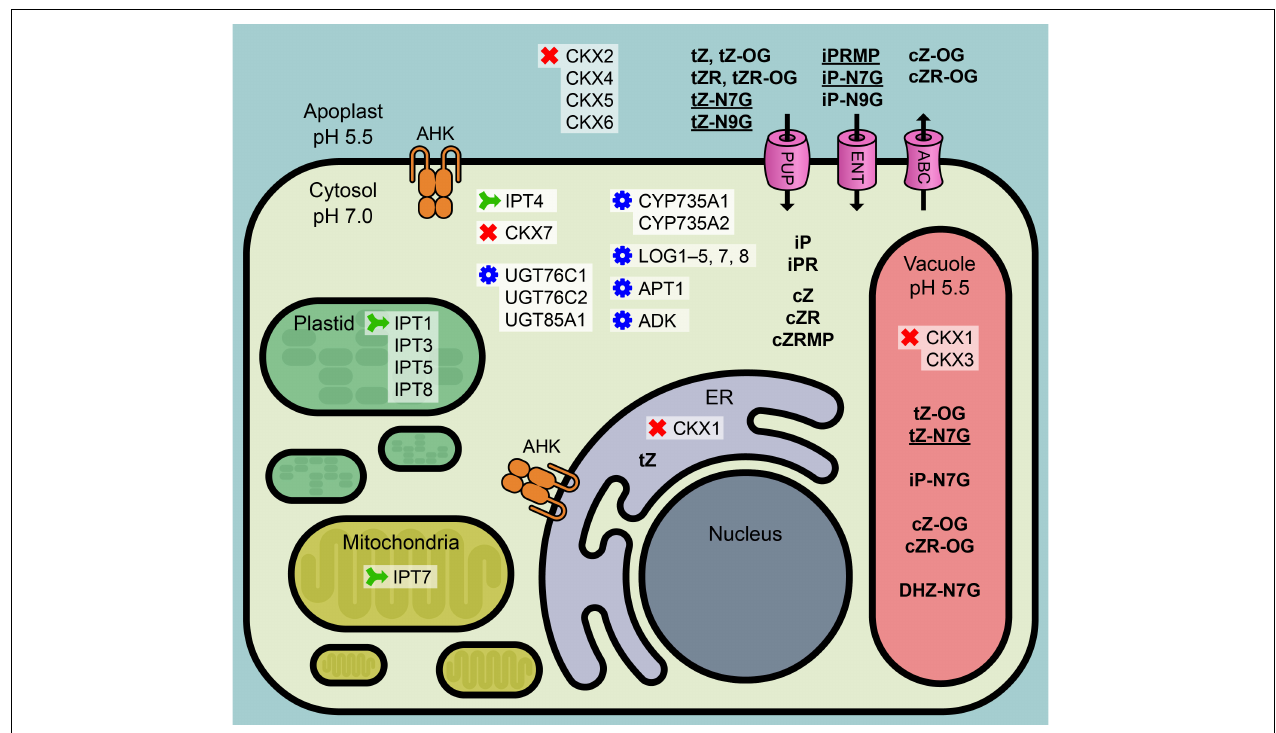
FIGURE 1 | Condensed overview of CK-related metabolic mechanisms in Arabidopsis cell. CK metabolic enzymes: green – biosynthesis, red – degradation, blue – conversion. IPT, isopentenyltransferase; UGT, UDP-glucosyltransferase; LOG, Lonely Guy, CK phosphoribohydrolase; CYP735A, cytochrome P450 mono-oxygenase; APT, adenine phosphoribosyltransferase; ADK, adenosine kinase; CKX, cytokinin oxidase/dehydrogenase. Pink – possible plasma membrane transporters: PUP, purine permeases; ENT, equilibrative nucleoside transporters; ABC, ABC transport proteins. Orange mark: AHK, Arabidopsis histidine kinase; ER, endoplasmic reticulum. Bold: CK metabolites; bold underlined: dominant CK metabolites. Based on the data published in Moffatt et al. (2000), Werner et al. (2003), Kasahara et al. (2004), Takei et al. (2004), Galuszka et al. (2007), Lizák et al. (2008), Kuroha et al. (2009), Zhang et al. (2013), Jiskrová et al. (2016), and Romanov et al.